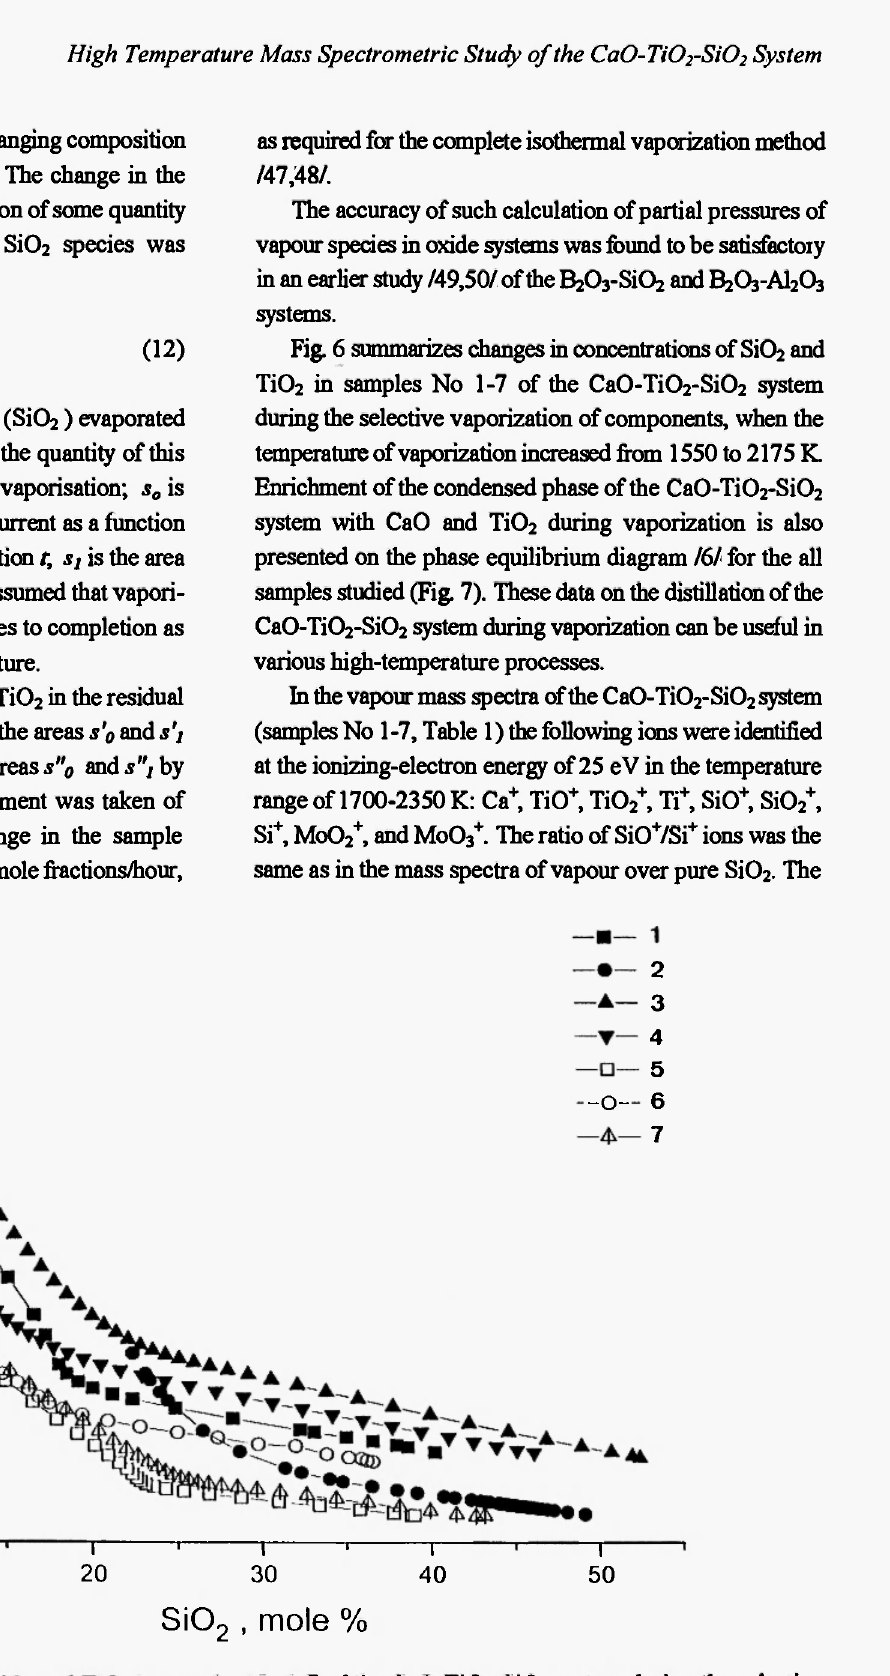
Fig. 6: Changes in concentration of Si0 vaporization of components, when the temperature of vaporization increased from 1750 to 2175